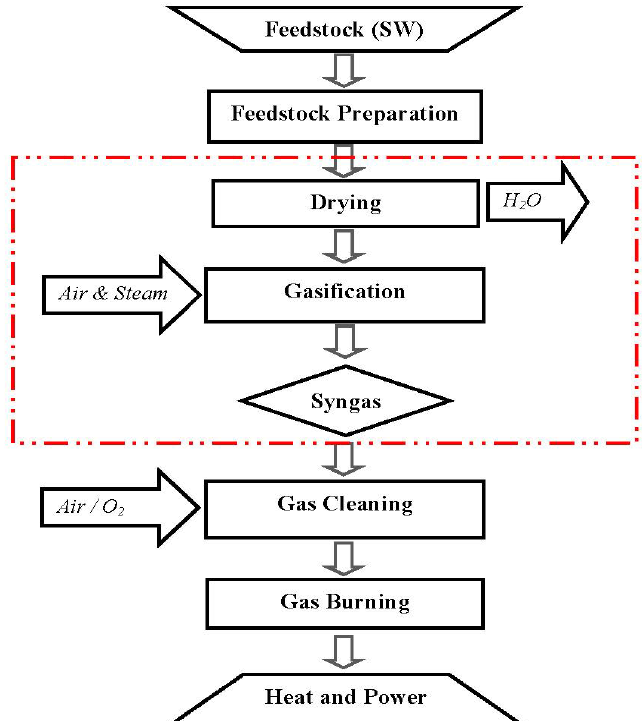
Figure 2. Schematic diagram of solid waste